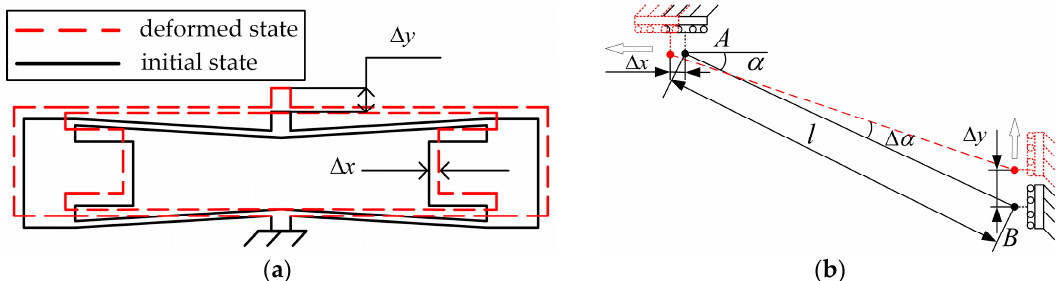
Figure 4. The schematic of hourglass amplification mechanism. ( a ) Working principle diagram of hourglass displacement amplification mechanism; ( b ) Motion model of quarter hourglass amplification mechanism.